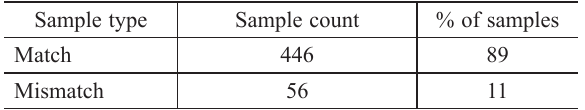
Table 2. The alerts produced by the method in the laboratory